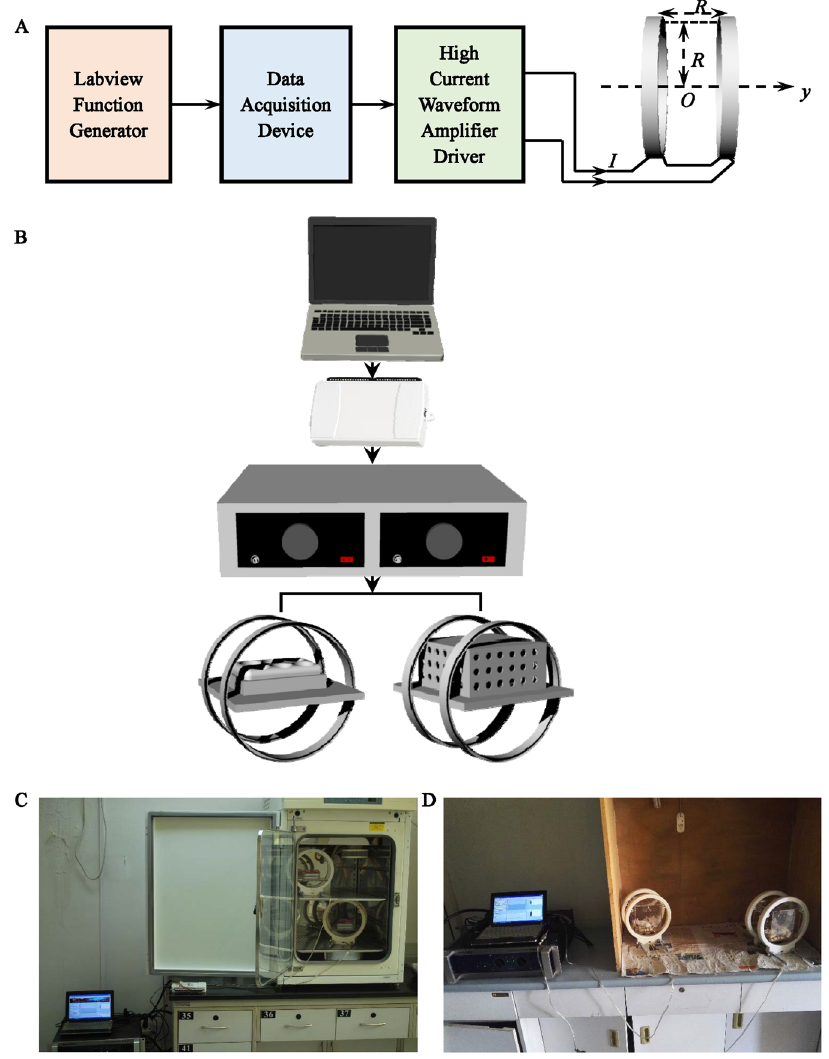
Figure 1. Representation of the system used to generate EMF. ( A ) The principle block diagram of EMF system. The device consists of four main parts: Labview software, multifunction data acquisition device, power amplifier and Helmholtz coils. ( B ) The simulated effect diagram of the system. ( C ) The physical photo of EMF system in the